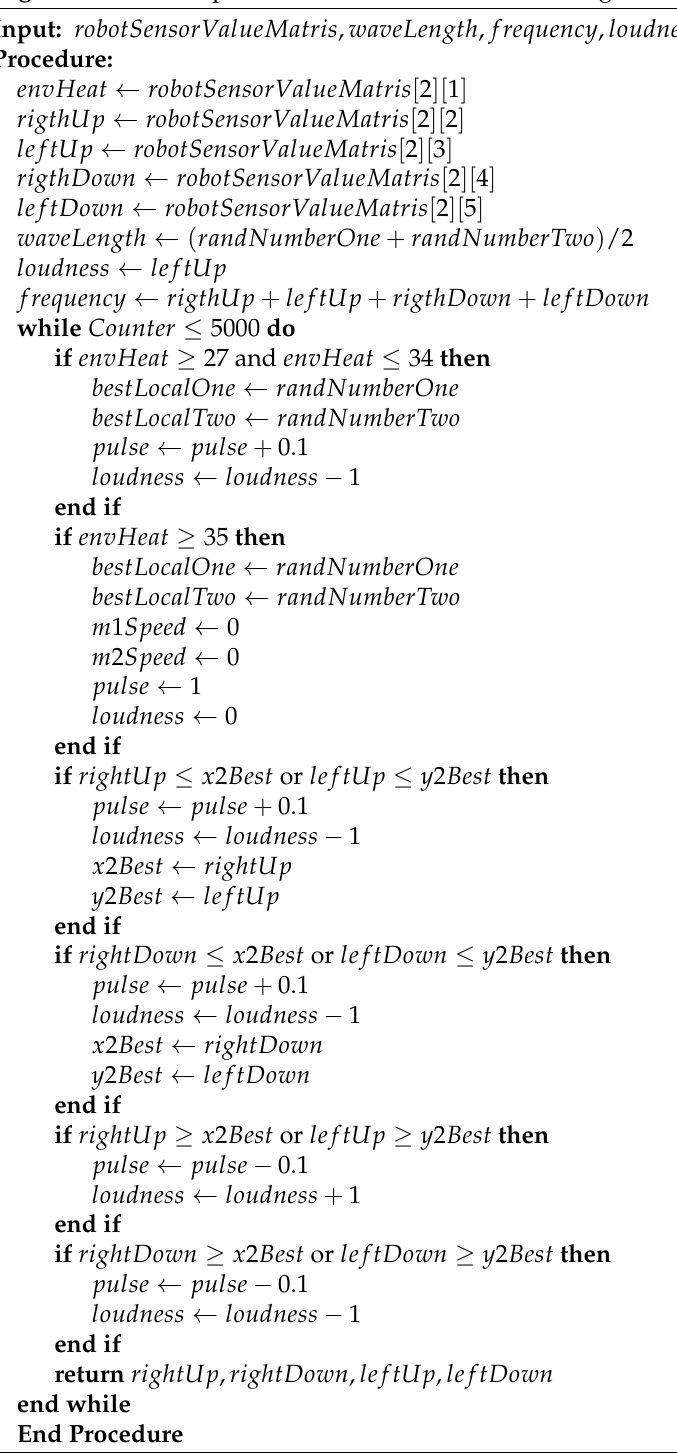
Algorithm 2 Bat-Inspired Multi-Robot Coordination